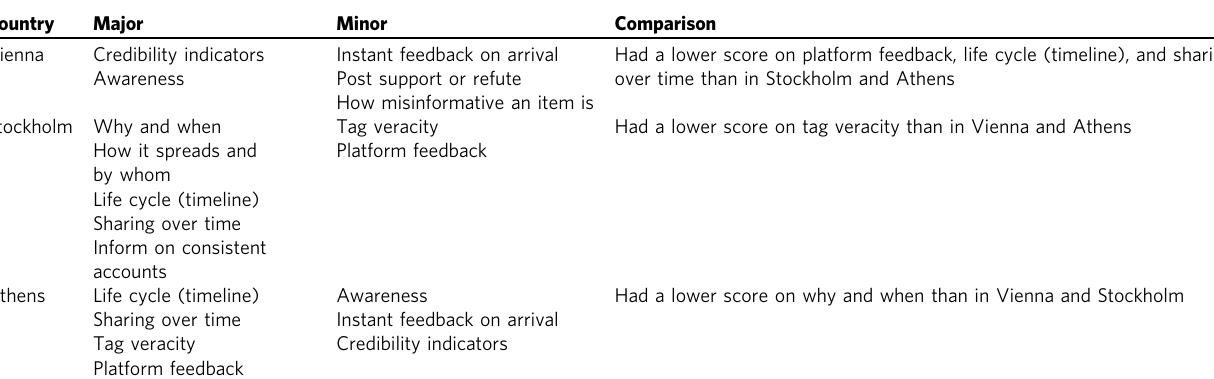
Table 2 Citizen preferences in Vienna, Stockholm and